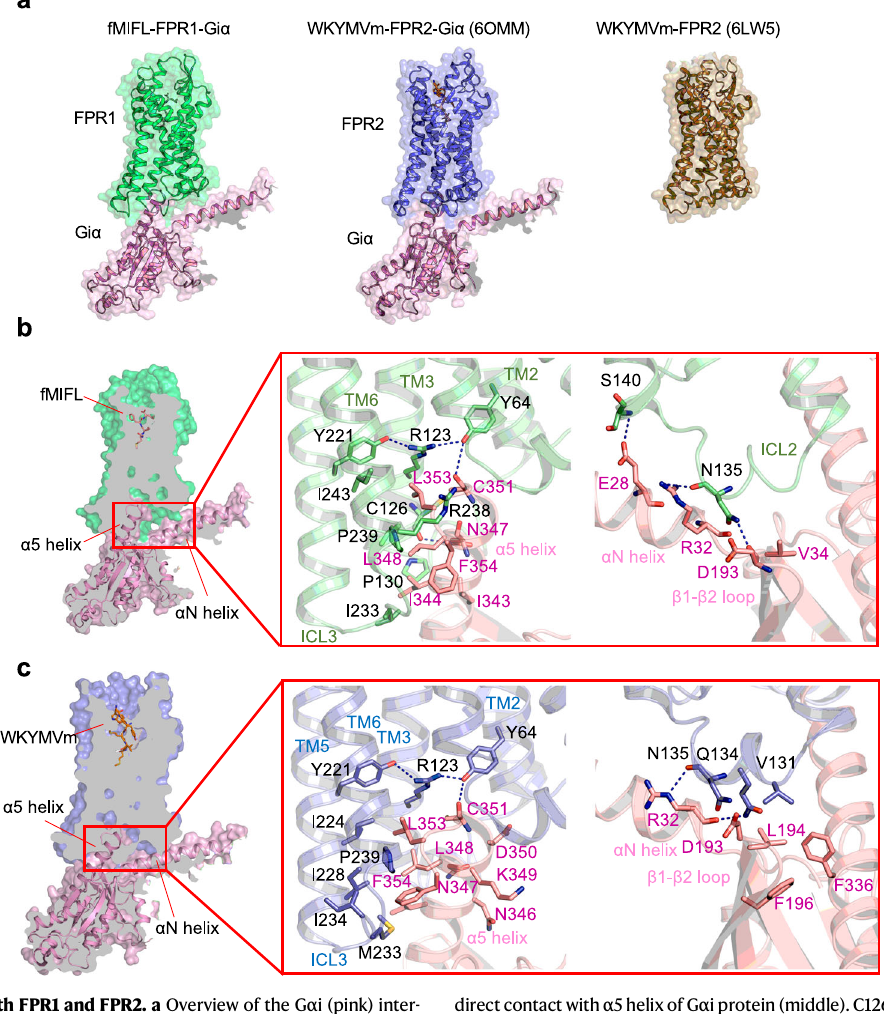
directcontactwith α 5helixofG α iprotein(middle).C126inTM3,Y64inTM2forms hydrogen bond to N347, N351 in α 5 helix of G α i protein, respectively. ICL2 of FPR1 has polar interactions with α N helix and β 1- β 2 loop of G α i protein (right). c Slab view showing the interactions between FPR2 and α 5 helix of G α i protein (left), as well as interactions of ICL2 of FPR2 with α N helix and β 1- β 2 loop of G α i pro- tein